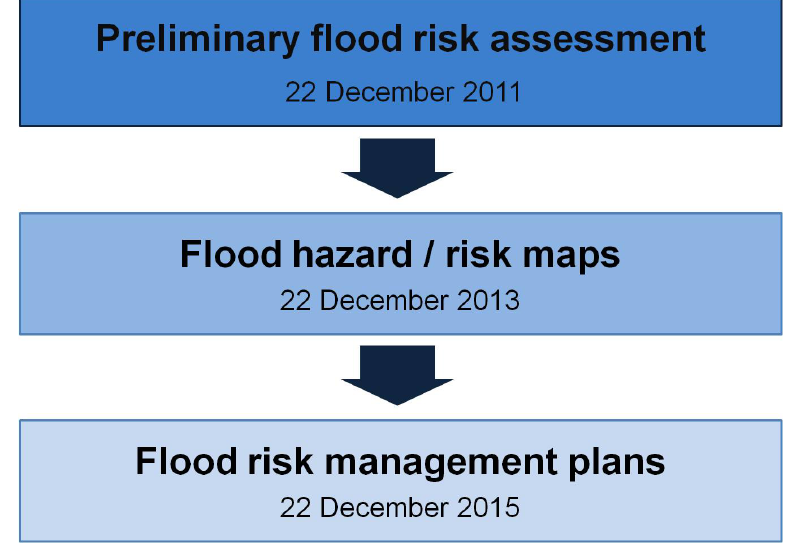
Figure 1. The three implementation steps of the European Floods